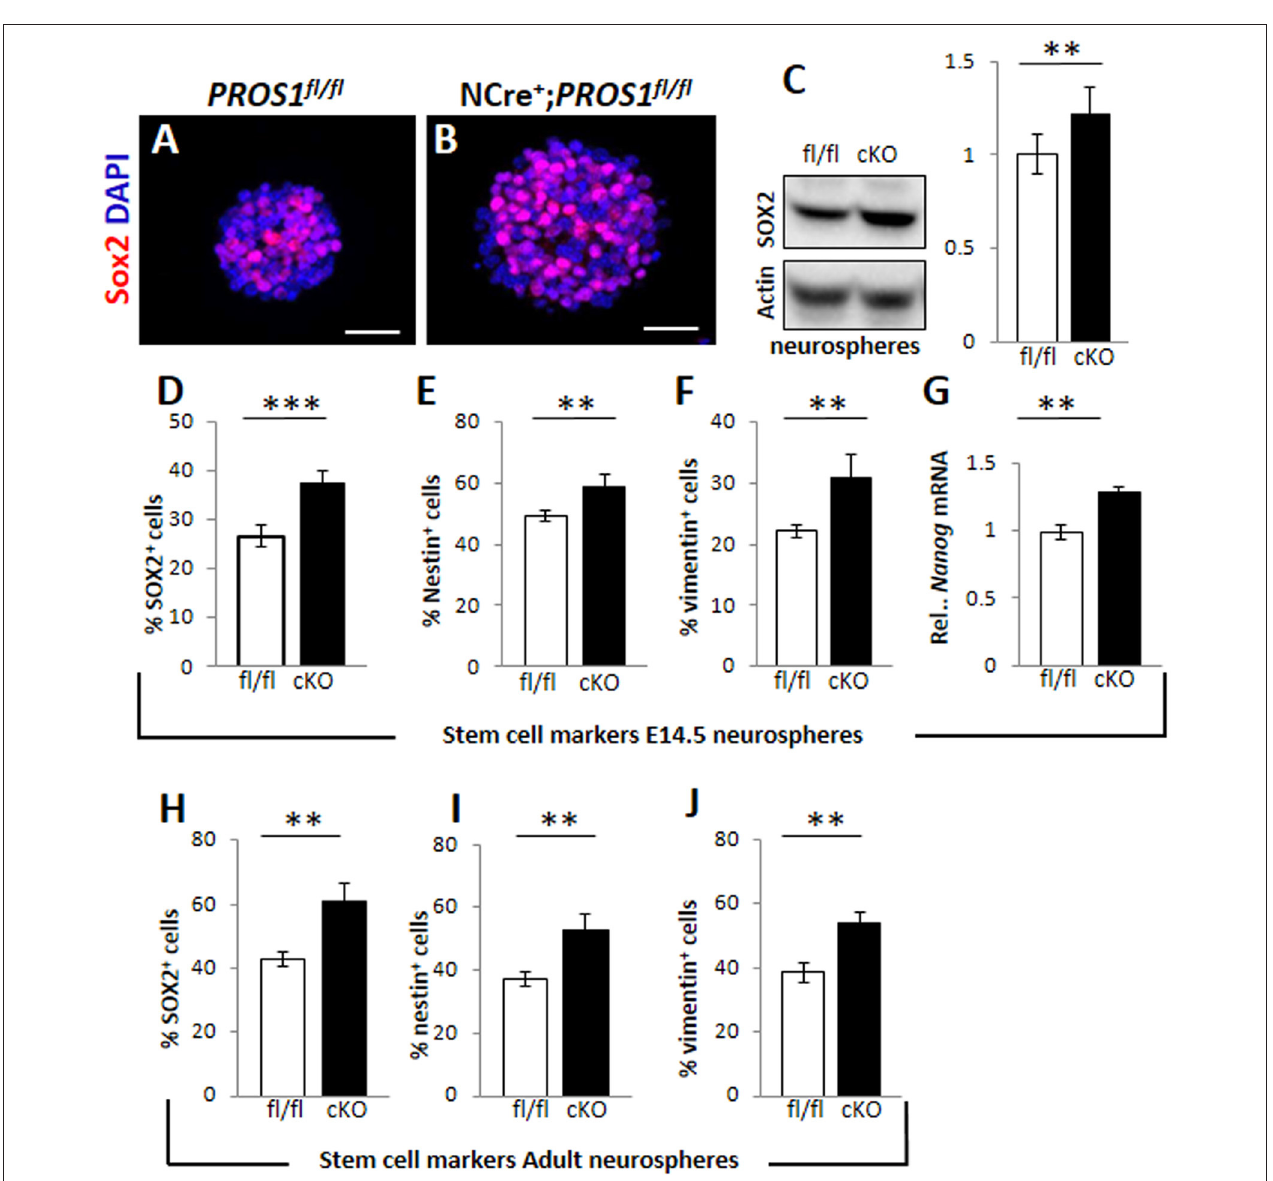
FIGURE 2 | Increased cell numbers expressing neural stem cell markers in neurospheres derived from Pros1 -cKO NSCs. (A,B) Representative confocal images of Sox2 immunoreactivity in neurospheres generated from E14.5 control (A) and Pros1 -cKO (B) NSCs. Scale bar: 50 µ m. (C) Western blot analysis of Sox2 expression in culture-grown neurospheres. Whole cell extracts were isolated from spheres and subject to analysis. Actin reactivity serves as a loading control. Band intensities were quantified using NIH image J software. A blot representative of at least three different experiments is shown. Quantification of graphs represent mean values and standard errors from at least three independent experiments. ** P = 0.008. (D–G) Quantification of cells expressing the neural stem cell protein markers Sox2 ( D ; P = 0.00066), Nestin ( E ; P = 0.01), vimentin ( F ; P = 0.01), and RT-qPCR relative expression levels of nanog ( G ; P = 0.01) in control and Pros1 -cKO neurospheres generated from E14.5 embryos. Mean values and standard errors were derived from five individual experiments. A minimum of three and up to five embryos per genotype were pooled in each experiment. (H–J) Quantification of cells expressing the neural stem cell protein markers Sox2 ( H ; P = 0.0012), Nestin ( I ; P = 0.0038), vimentin ( J ; P = 0.0016) in control and Pros1 -cKO neurospheres generated from adult SGZ NSCs. Pooled cells from 3 to 4 mice per genetic group were used for each experiment. Mean values and standard errors were derived from four individual experiments. *** P ≤ 0.001; ** P ≤